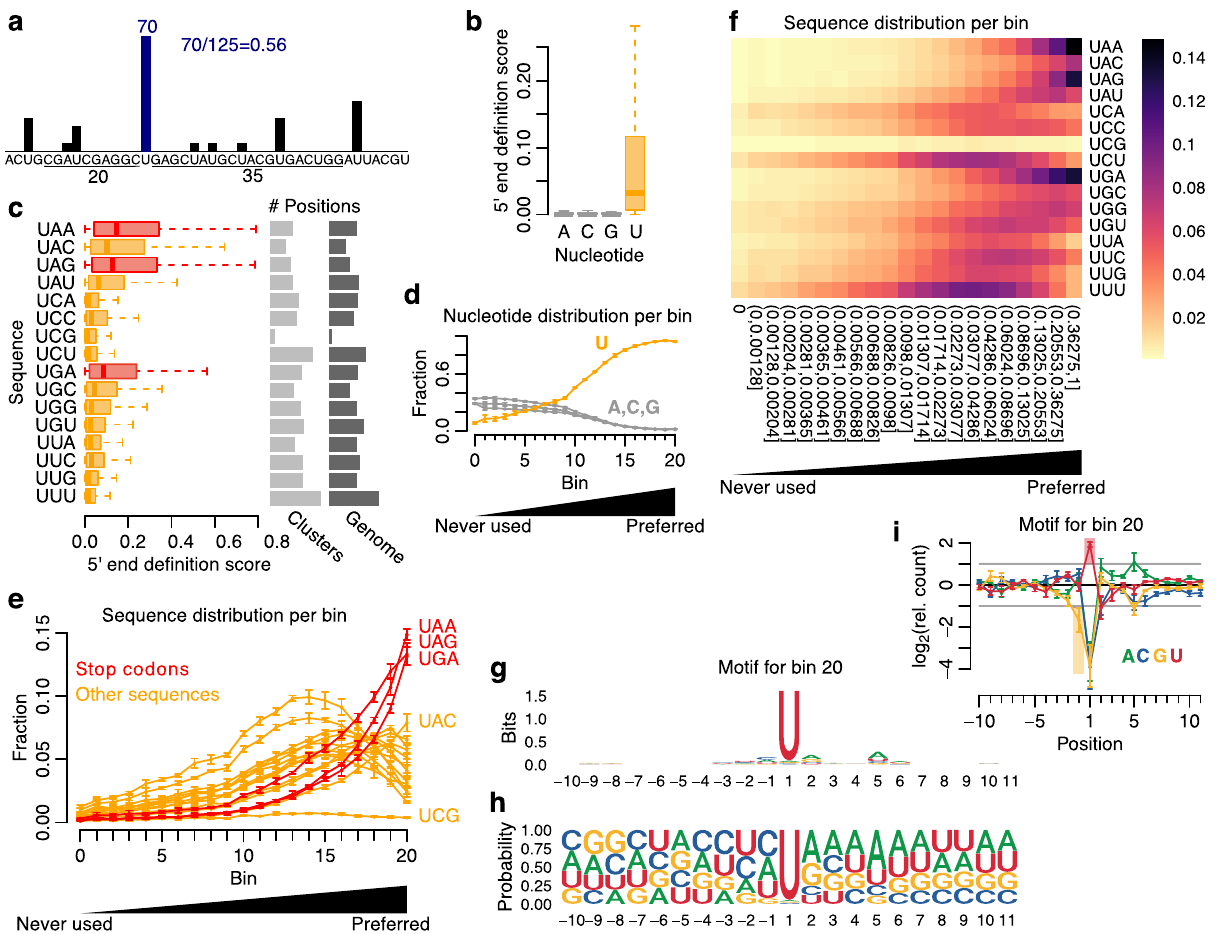
Fig. 4 Deciphering the cleavage preference of PLD6. a Illustration of the 5 ′ end de fi nition score. b Boxplot showing 5 ′ end de fi nition score per nucleotide using pooled data (5 replicates). c Boxplot showing 5 ′ end de fi nition score per Unn sequence. Stop codons are shown in red and the remaining sequences in orange. The number of positions per sequence is shown to the right. The data were pooled (5 replicates). d Line graph showing nucleotide fraction per bin. Fraction shown as mean ±sd (5 replicates). e Line graph showing Unn sequence fraction per bin. Fraction shown as mean ±sd (5 replicates). f Heatmap showing 5 ′ end sequence distribution per bin. The 5 ′ end de fi nition score thresholds are shown under each column. Fraction calculated as mean across 5 replicates. An extended fi gure with all sequences is available as Supplementary Fig. 5a. g Sequence motif around positions from bin 20 (pooled signal, 5 replicates). h Nucleotide frequency around positions from bin 20 (pooled signal, 5 replicates). i Nucleotide enrichment around positions from bin 20 (pooled signal ±sd, 5 replicates). An extended fi gure with all bins is available as Supplementary Fig. 5b. Boxplots show median (central line), interquartile range (IQR, box), and minimum and maximum values (whiskers, at most 1.5*IQR). Additional analyses using a second dataset are available in Supplementary Fig. 6 and Supplementary Fig. 7. Source data are provided as a Source Data fi